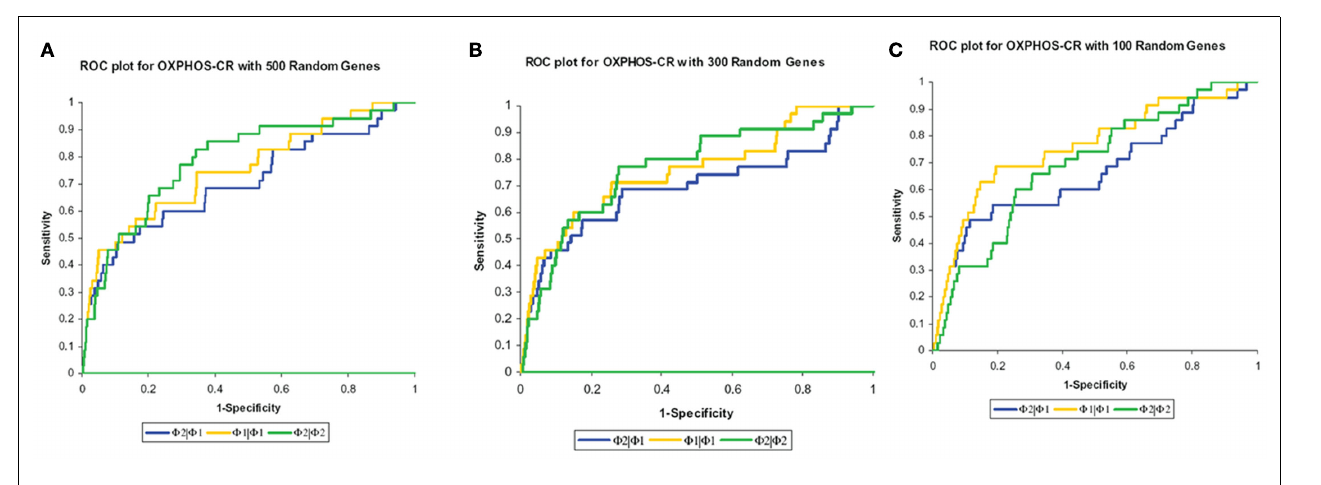
genes dataset. (B) ROC plot of the rankings of the classifications from the added 300 random genes dataset. (C) ROC plot of the rankings of the classifications from the added 100 random genes